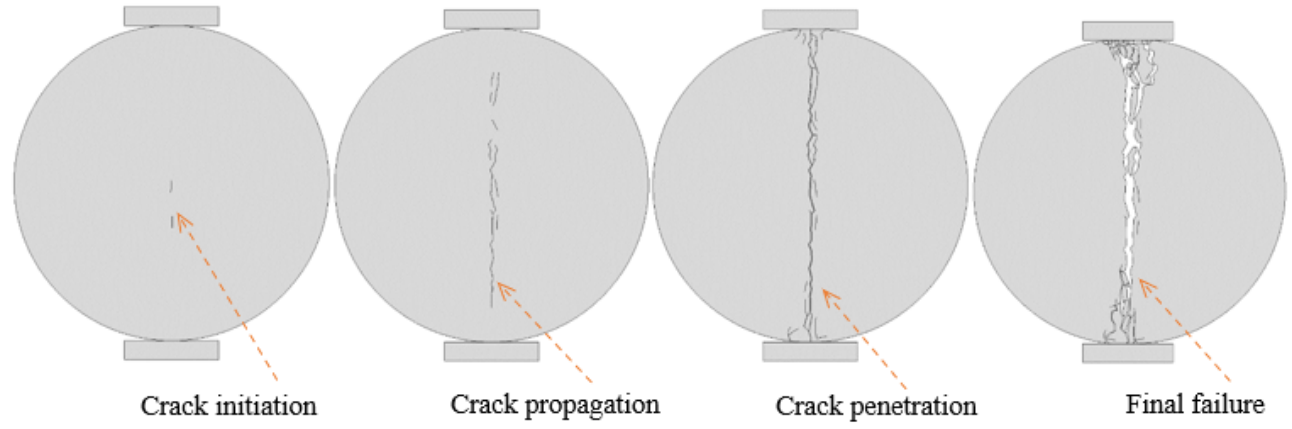
Figure 9. Failure process for the Type II Brazilian disc testing.